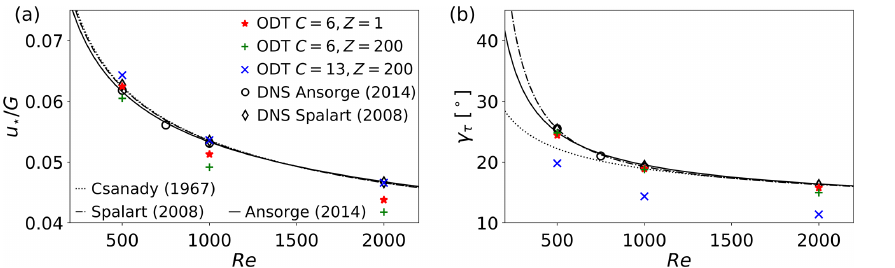
Figure 3. (a) Normalized friction velocity u ∗ /G and (b) surface wind-turning (wall-shear) angle γ τ as function of Re for various sets of ODT model parameters (filled symbols) in comparison to reference DNS (open symbols) and theory (lines) compiled from Csanady (1967); Spalart et al. (2008); Ansorge and Mellado (2014). See the text and Table 1 for details. Table 1. Parameterization coefficients for the turbulent drag over a smooth surface.